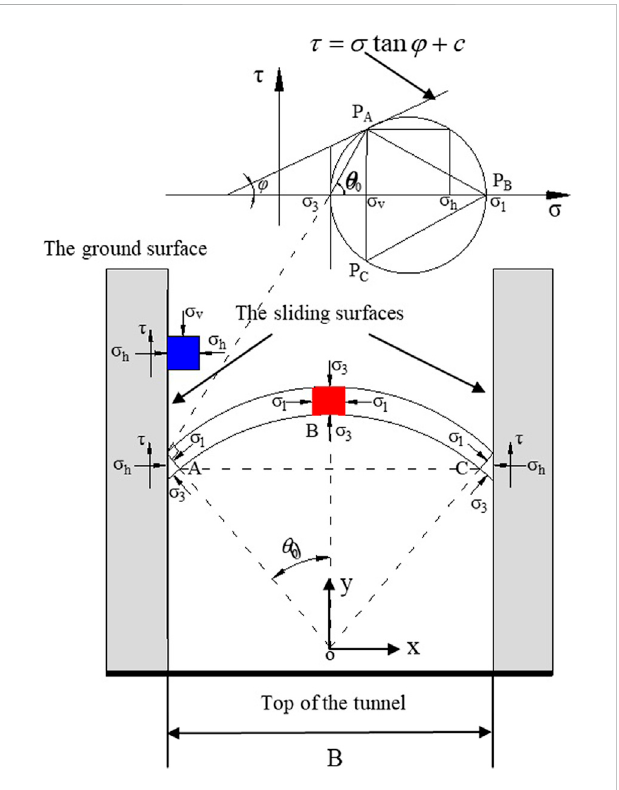
FIGURE 3 Analysis model of lateral earth pressure coef fi